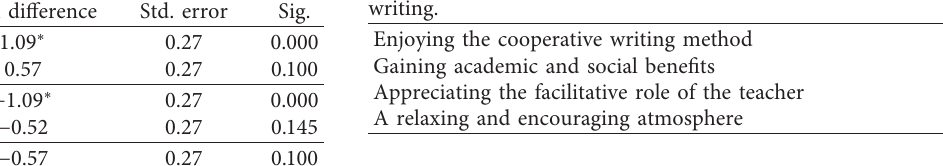
Table 7: Results of the post hoc test for writing complexity. Groups Groups